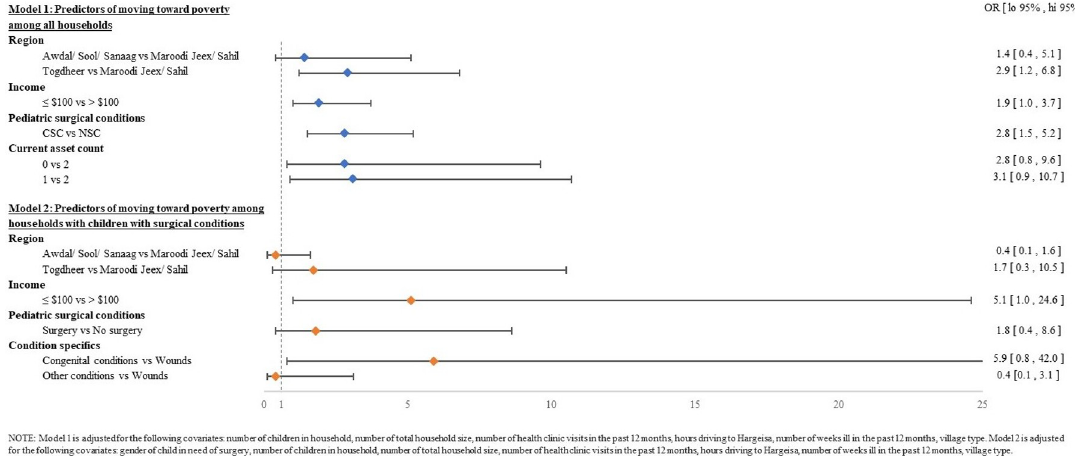
Fig 3. Predictors of moving towards